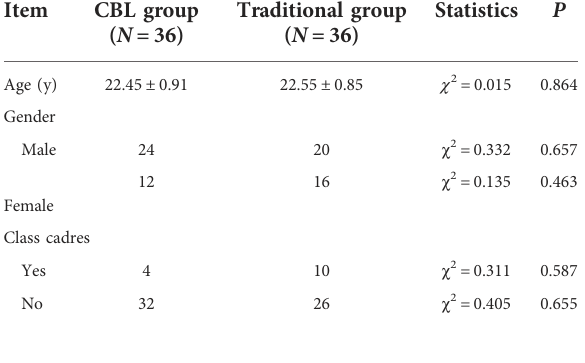
TABLE 1 The basic characteristics of all the